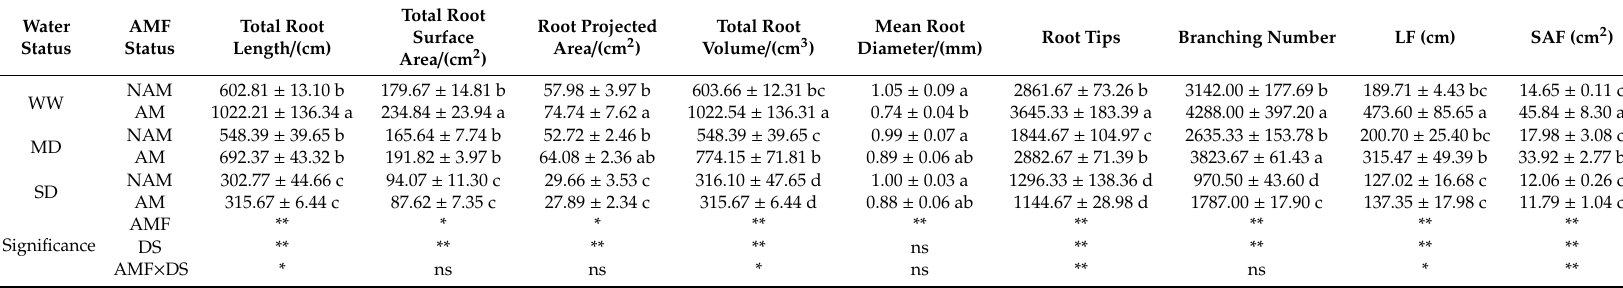
Table 4. E ff ect of the arbuscular mycorrhizal fungus (AMF) Rhizophagus intraradices on the root morphological parameters of Catalpa bungei seedlings under DS. Water